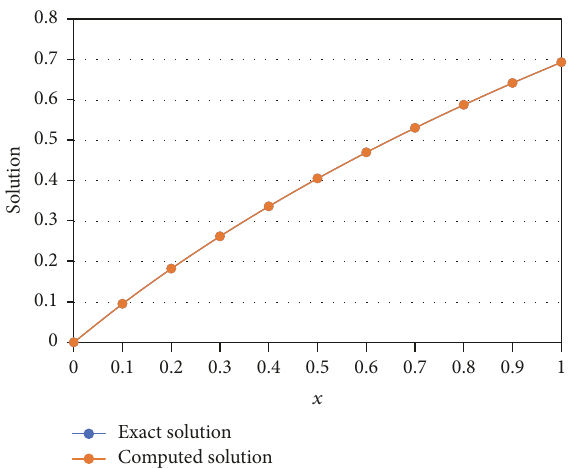
Figure 1: Comparison of the exact and computed solution of Example 7.